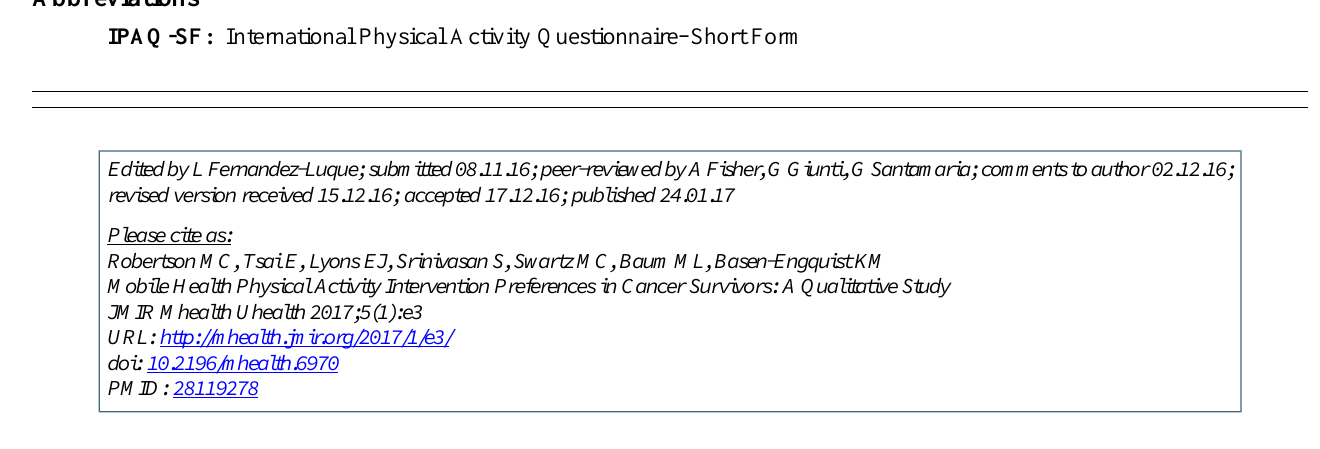
IPAQ-SF: International Physical Activity Questionnaire–Short